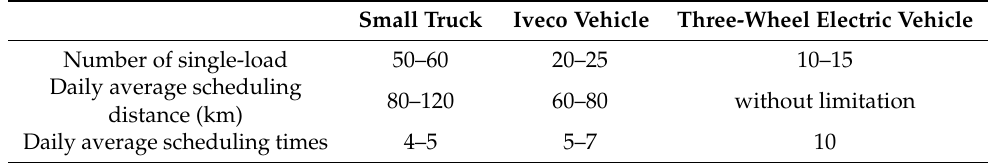
Table 1. Types and characteristics of dispatching